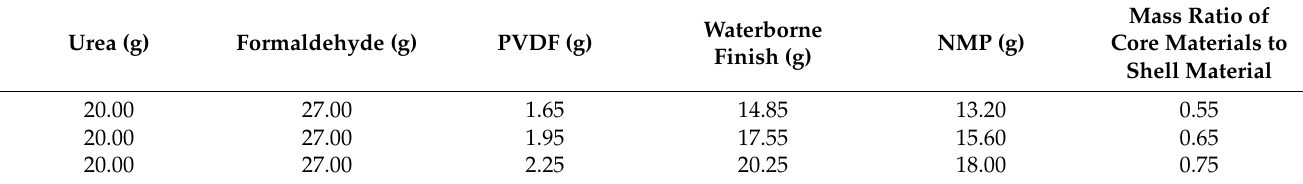
Table 1. Main components of fluororesin